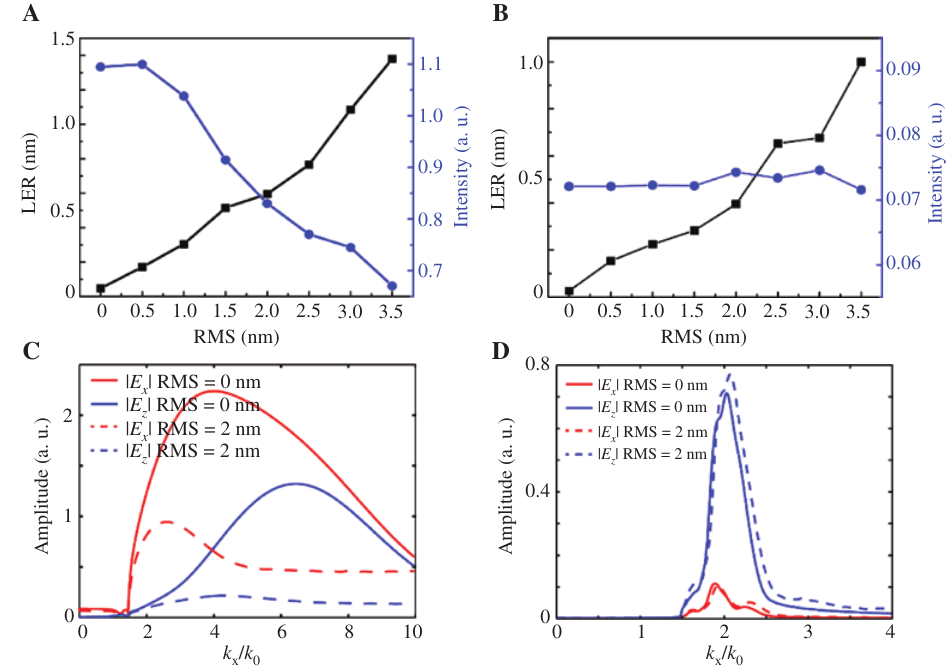
Figure 4: Comparisons of the patterning performance in both superlens and HMM systems with varied surface roughness. LER and electric field intensity variation of the patterns in the PR film as the RMS roughness increases in (A) superlens and (B) HMM, respectively. Normalized transmission amplitude of electric field components at the middle position of the PR film corresponding to the (C) superlens and (D) HMM with smooth and rough surfaces. All these data are extracted from the COMSOL simulation with the reflective layers involved in the two